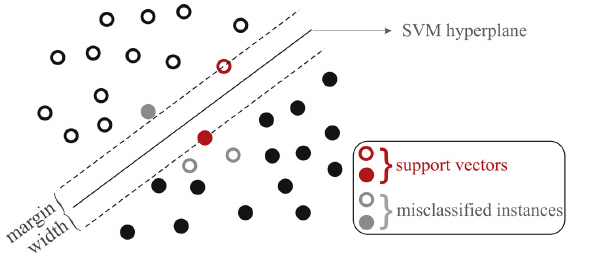
Figure 5: Example of the linear SVM by (San, 2014)